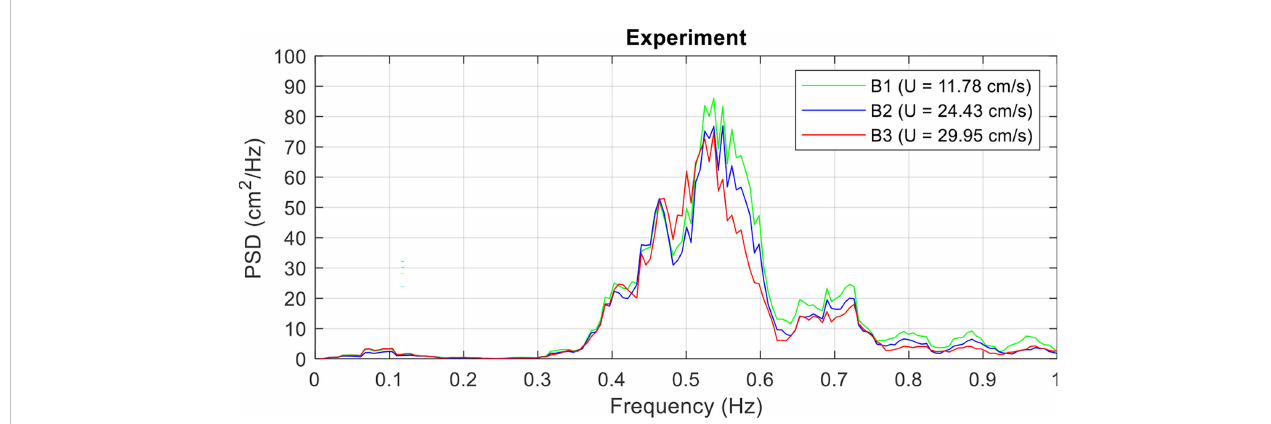
FIGURE 11 Power spectral density of the irregular waves with different coplanar current velocities.